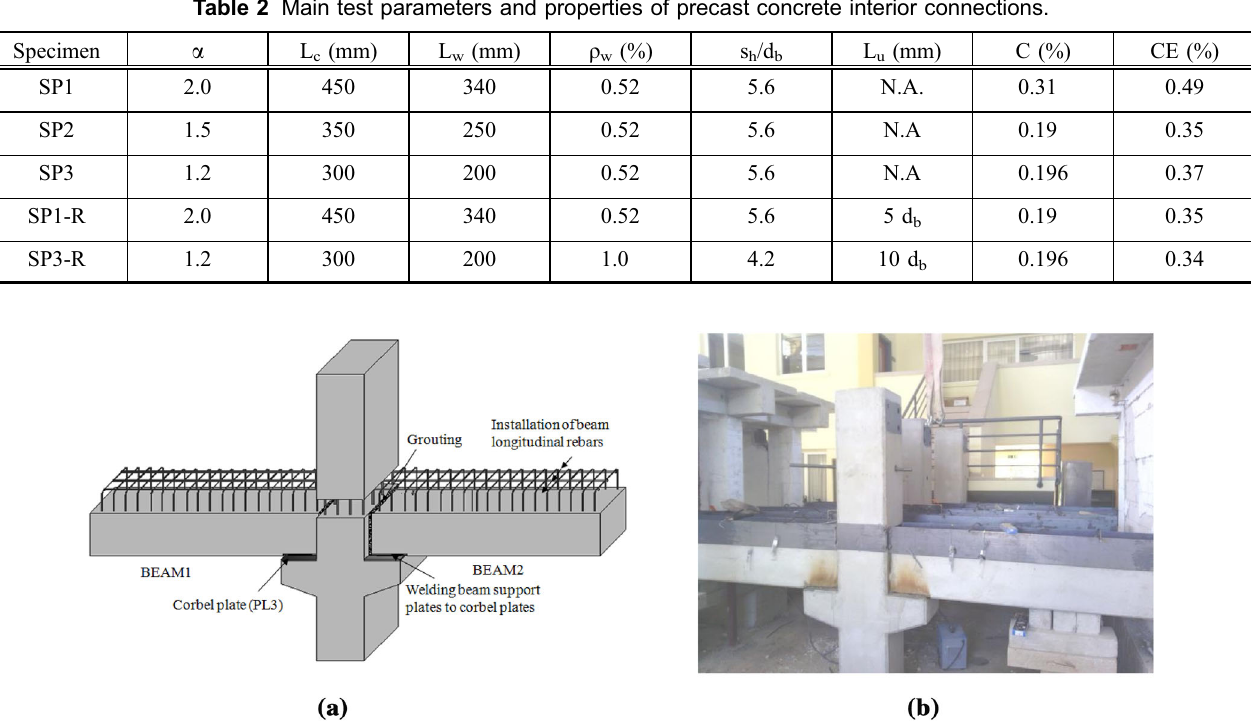
Fig. 7 a Installation process of precast beam-column connection specimens and b casting of topping concrete.